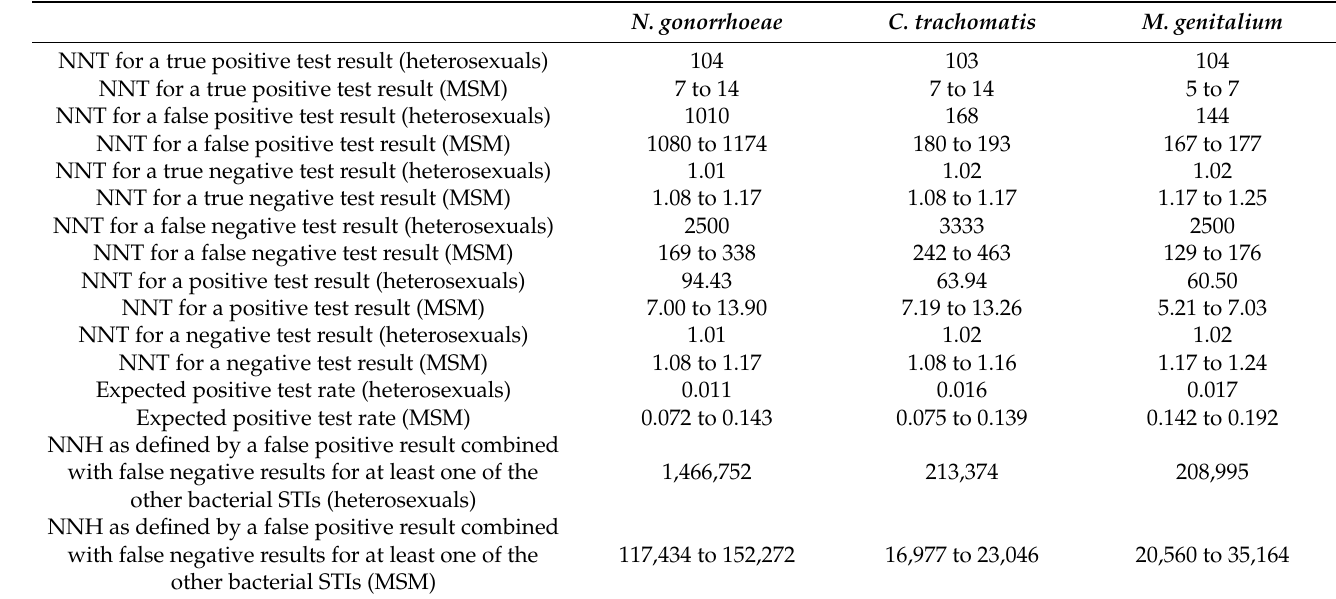
Table 3. Numbers needed to test (NNT) for a true positive test result per species, expected numbers of tests per species until a false positive result is seen, and species-specific numbers needed to harm (NNH) as defined by false positive results in the species-specific screening assay combined with false negative results for at least one of the other bacterial